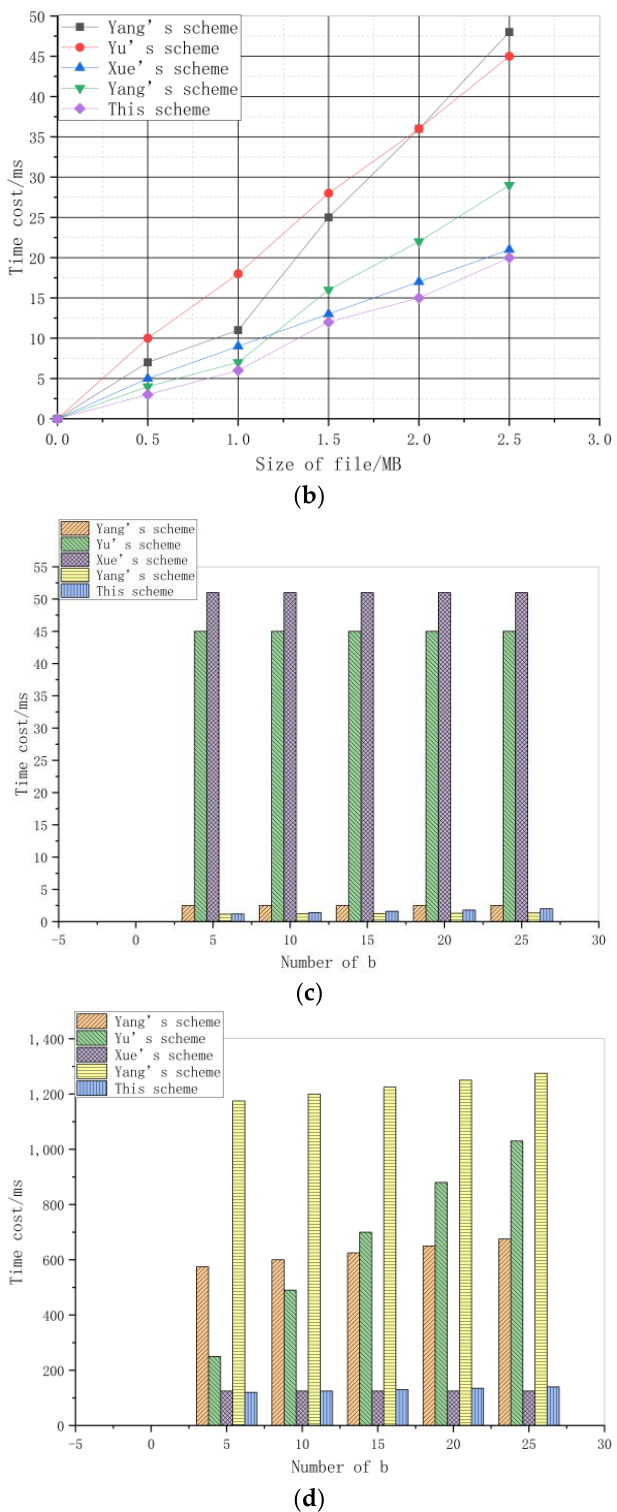
Figure 6. Experimental results of basic computing overhead: ( a ) Time cost of encryption; ( b ) time cost of decryption; ( c ) time cost of deletion; ( d ) time cost of verification.